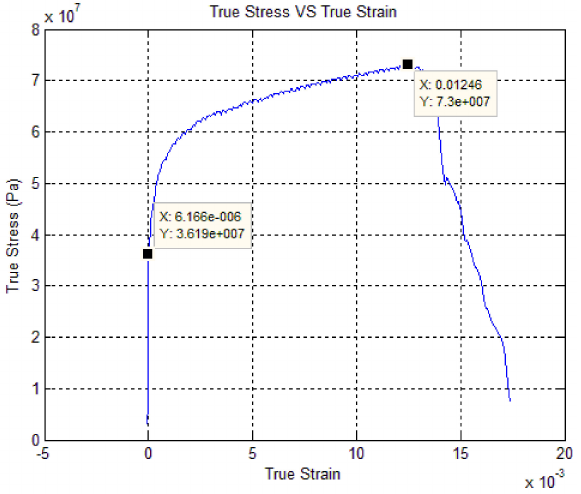
Figure 12. True stress vs. true strain graph for continuum